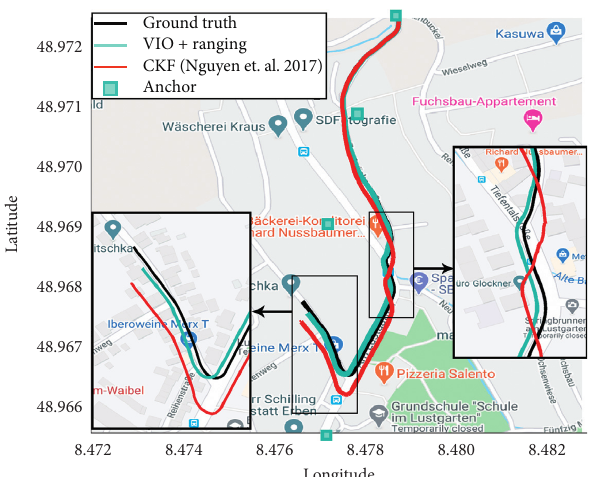
Figure 15: Position estimation result of dataset 2011_09_30_0034 presented on Google